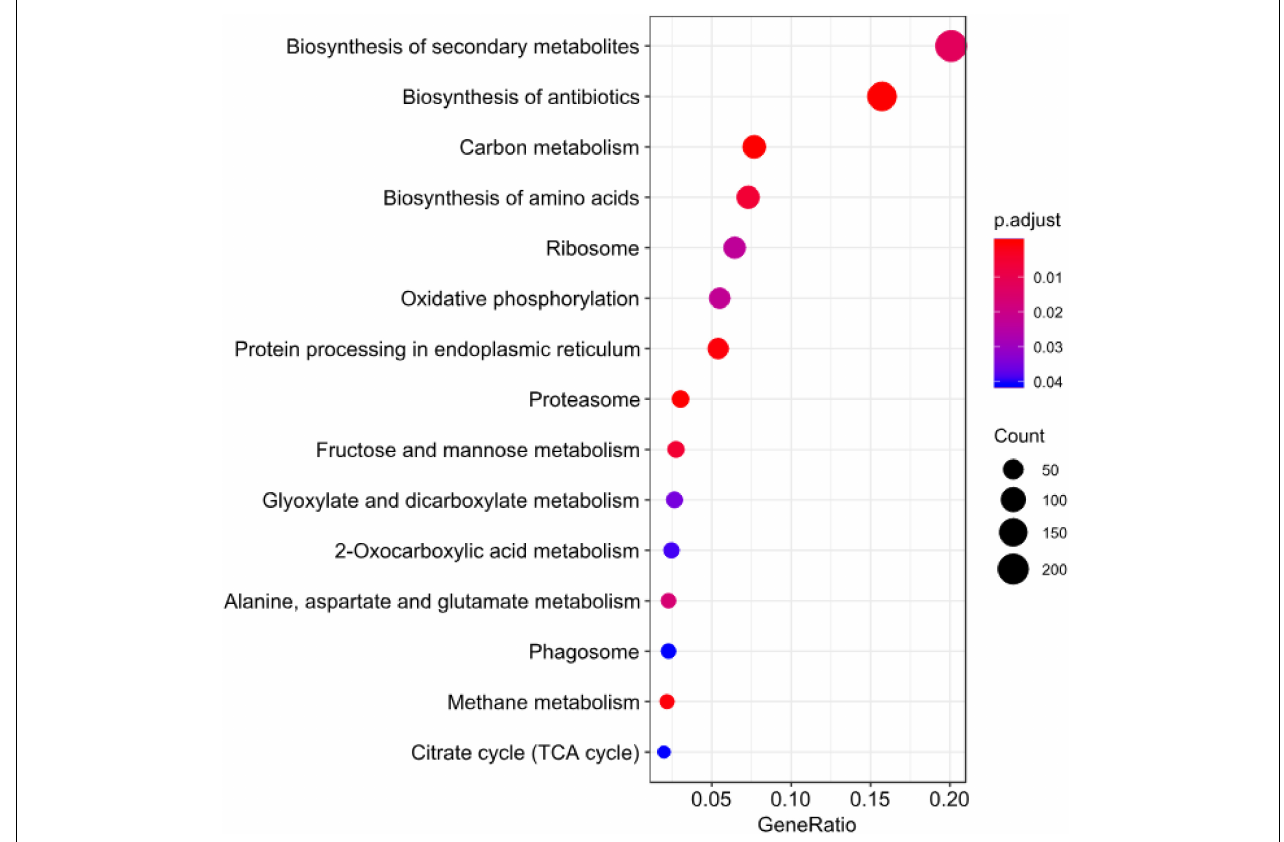
FIGURE 9 | KEGG enrichment analysis for DEGs of B. maydis in maize susceptible and resistant genotypes at 96 h post